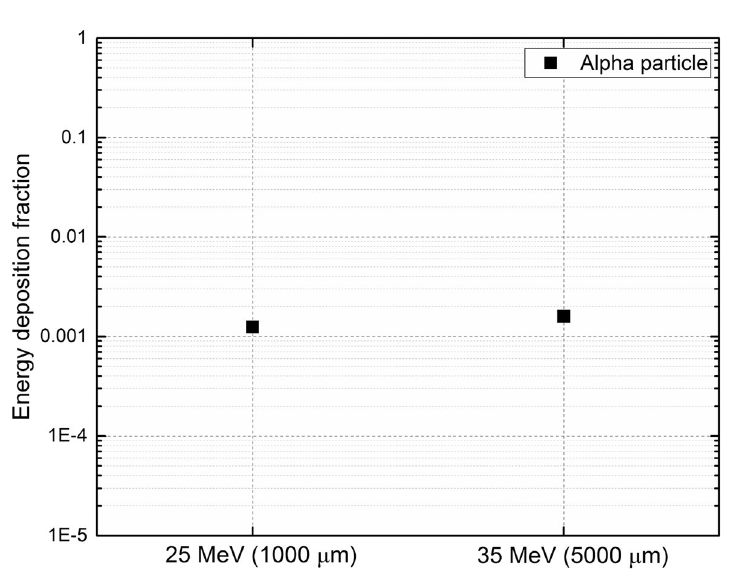
Figure 11. Fraction of energy deposition from alpha particles for (1) incident proton energy of 25 MeV with buffer medium thickness of 1000 µm, and (2) incident proton energy of 35 MeV with buffer medium thickness 5000 μm, both having boron filled cytoplasm and